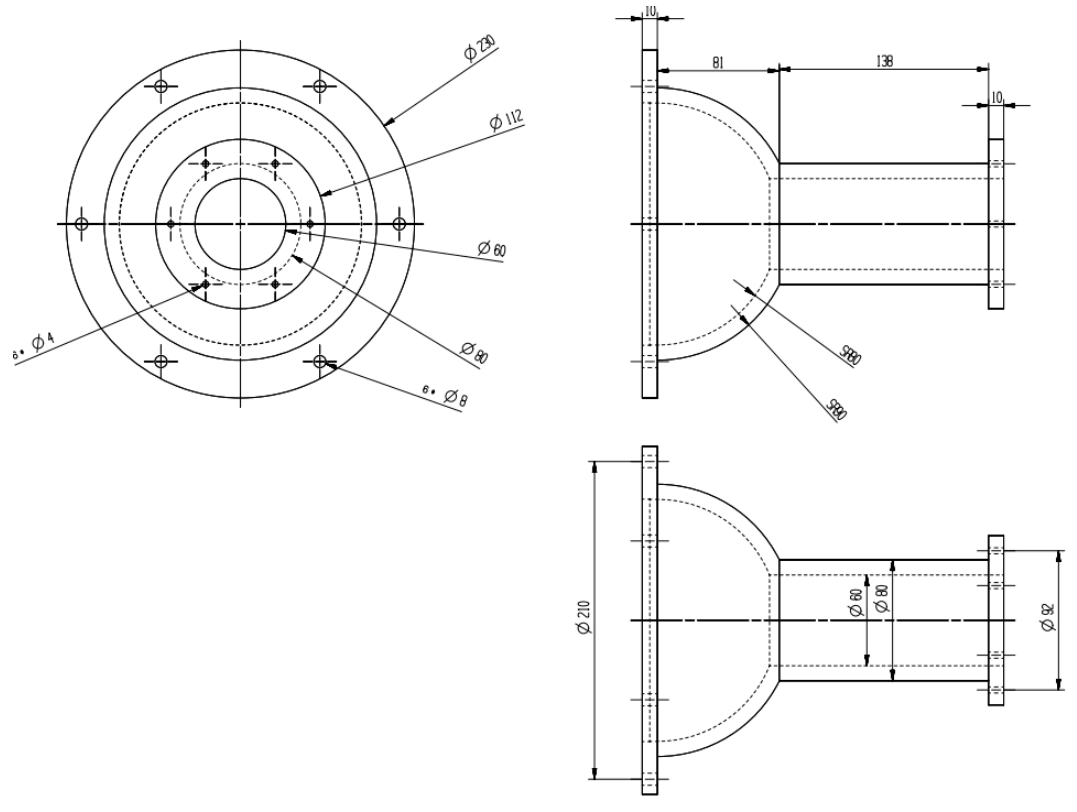
Figure 5. Dimensional design of the air inlet.